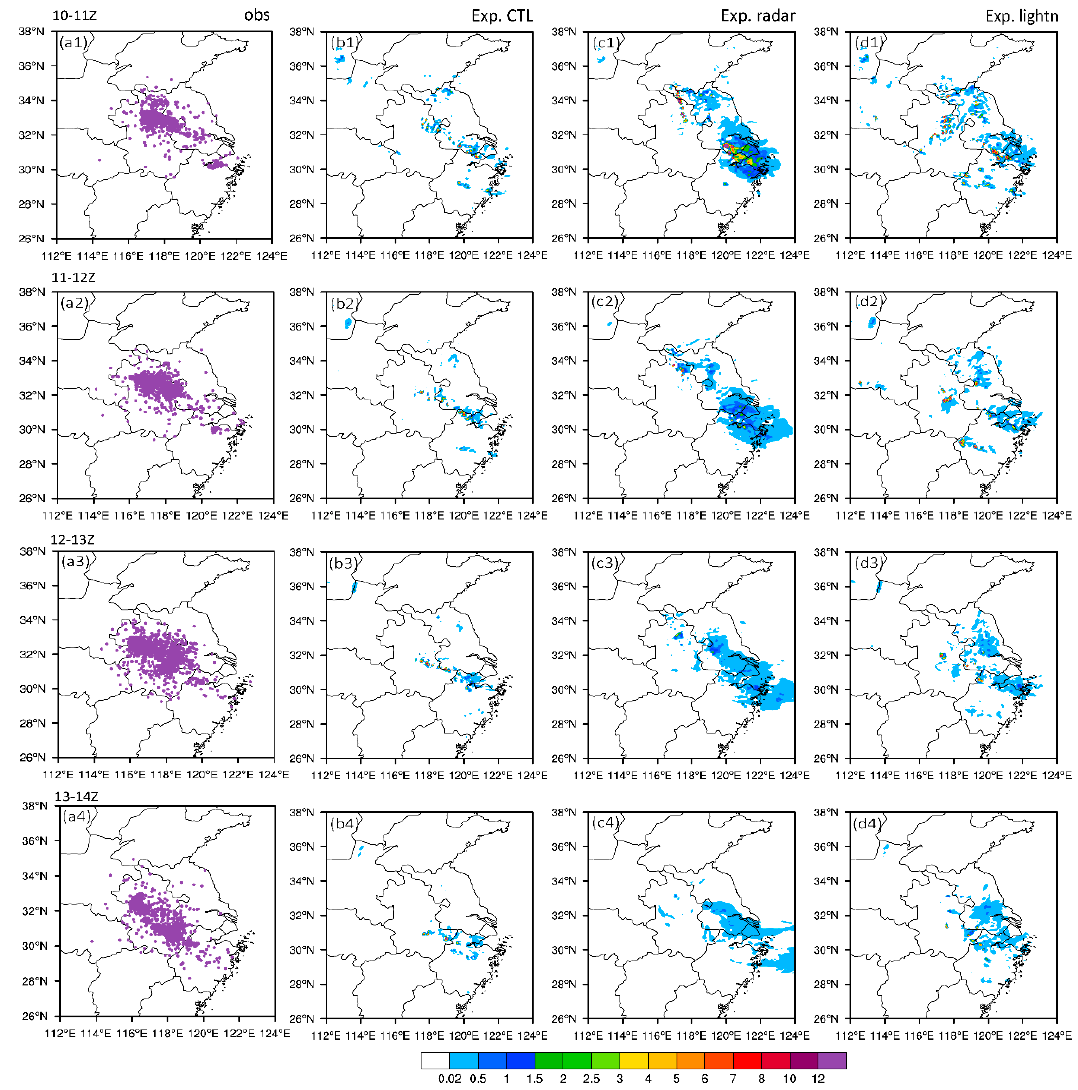
Figure 8. The observed cloud-to-ground lightning location ( a ) and the diagnosed lightning threat index (the weight sum of the formal two indexes (the weights are 0.95 and 0.05), LTI 03) of ( b ) Exp. CTL, ( c ) Exp. radar and ( d ) Exp. lightn hourly from 1000 to 1400 UTC. Row 1 to 4 represents different time interval from 1000 to 1400 UTC.